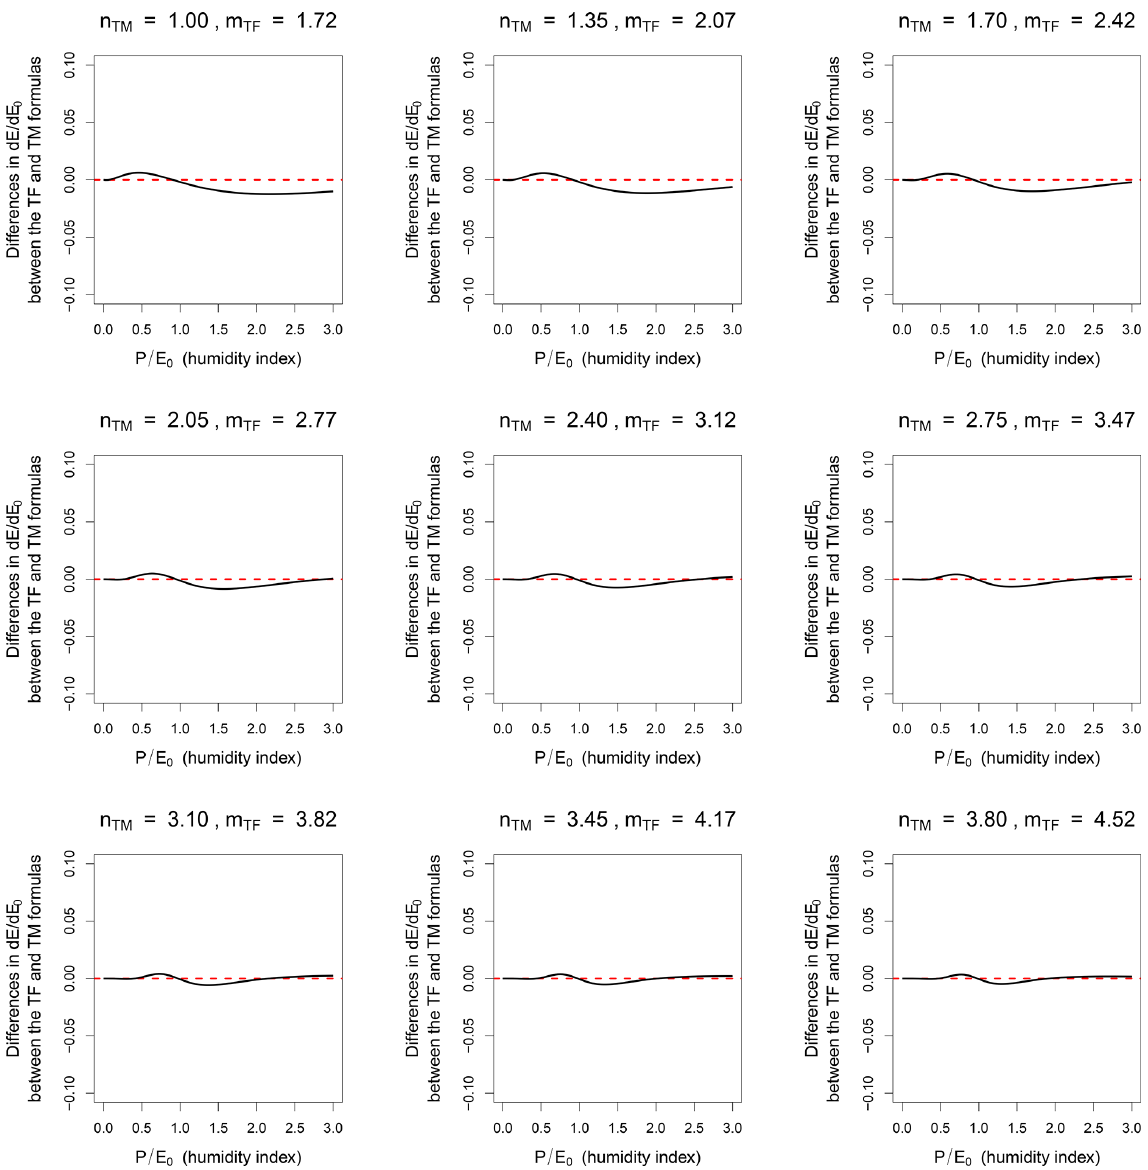
Figure 3. Illustration of the similarity between the Turc–Mezentsev (TM) and Tixeront–Fu (TF) formulas for a range of values of n (the parameter of the TM formula) and m (the parameter of the TF formula), using the Yang et al. (2008) relationship: m = n + 0 . 72: difference in the partial differentials ∂E ∂E 0